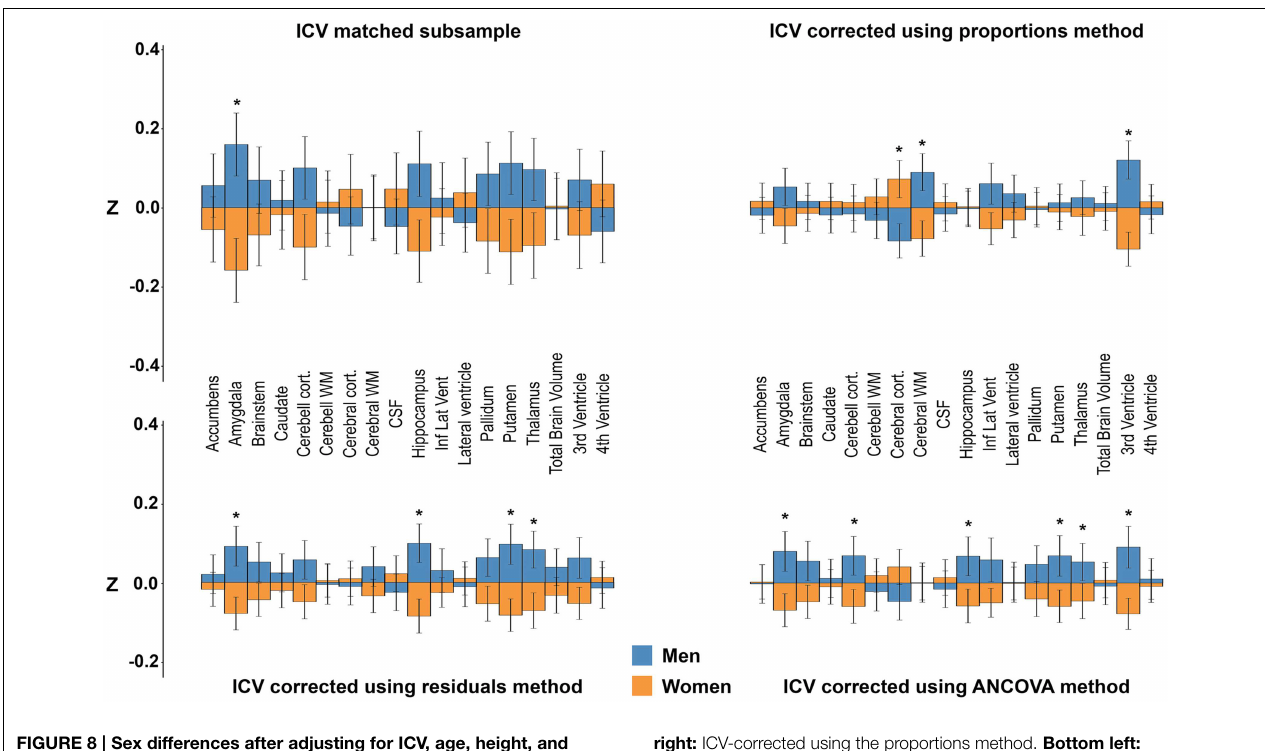
right: ICV-corrected using the proportions method. Bottom left: ICV-corrected using the residuals method. Bottom right: ICV-corrected using the ANCOVA method. * Corrected p < 0 . 05 . See Materials and Methods for details on how the covariates were included in the different